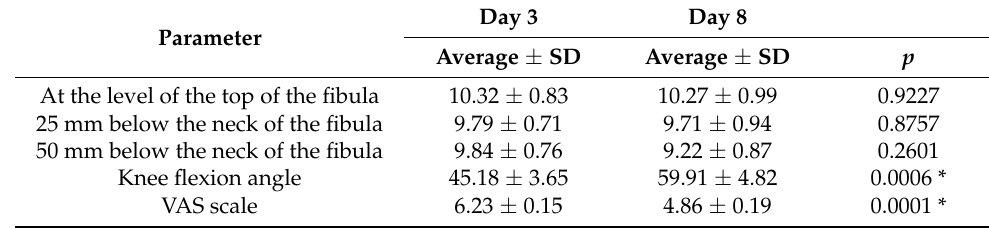
Figure 7. Evaluation of the VAS scale in the treatment group and clinical control groups. Table 3. The results obtained in the subgroups that did not receive Kinesio Taping.